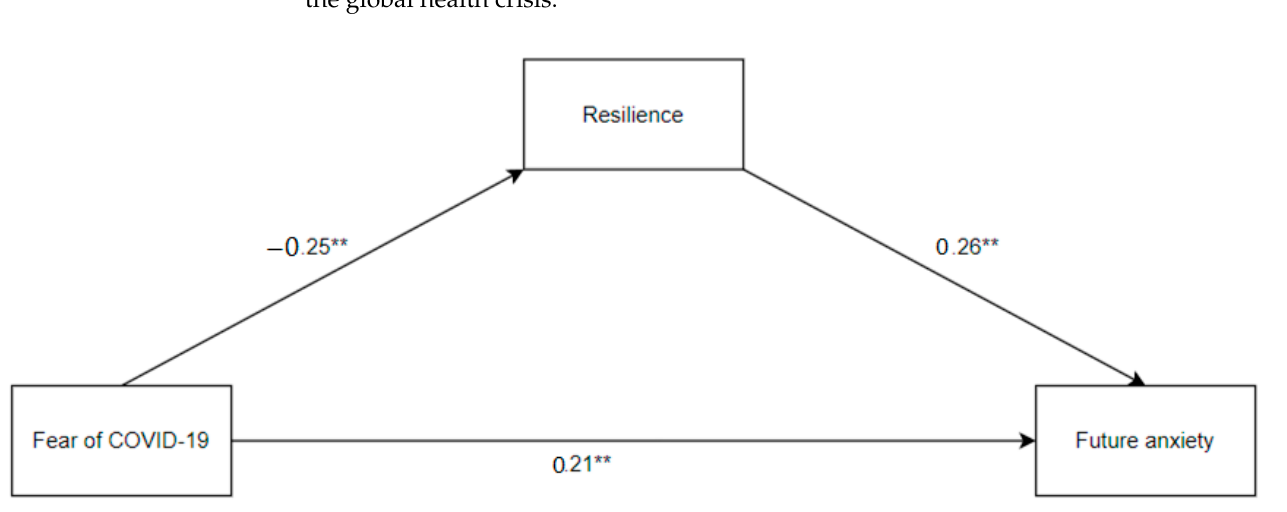
Figure 1. Mediation model depicting the associations between the variables. ** Correlation is significant at the 0.01 level (2-tailed). Table 3. Unstandardized coefficients for the mediation model ( n = 489).